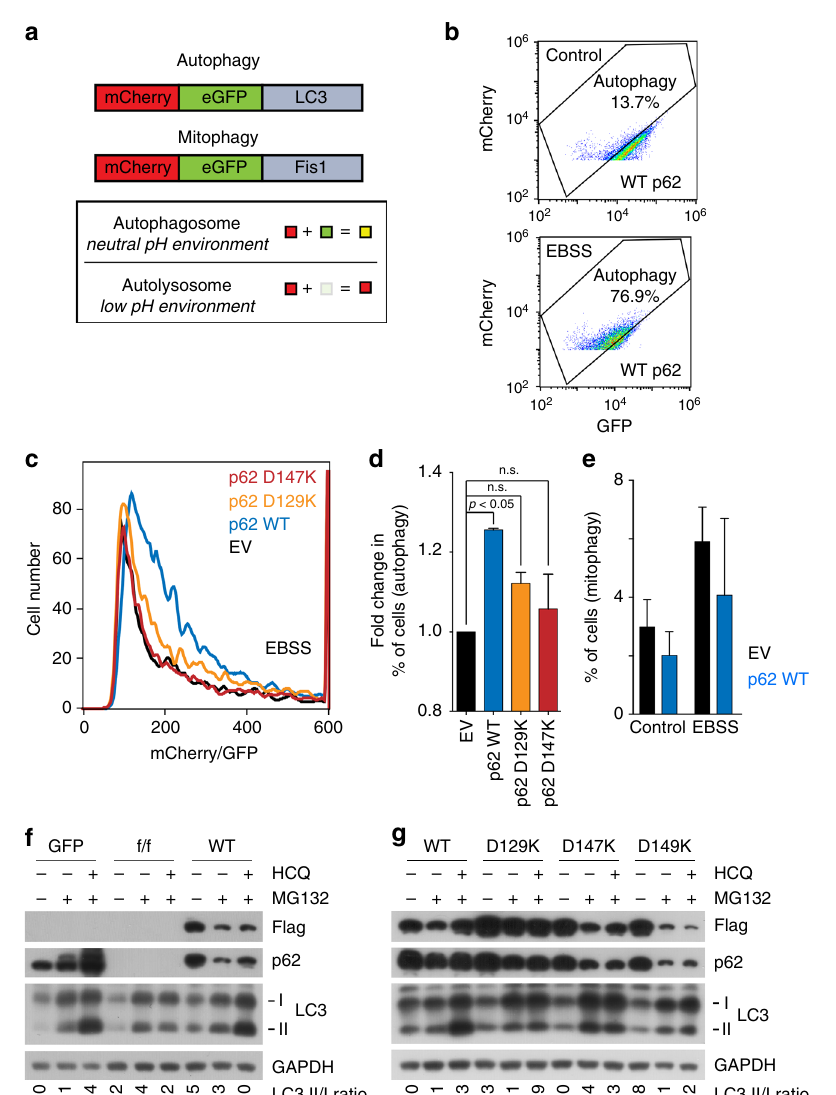
Fig. 4 p62zz is necessary for ef fi cient EBSS-induced macroautophagy. a Schematic of LC3 tandem and Fis-tandem fl ux assay. b An example of the LC3 tandem fl ow cytometry assay under basal conditions or starved (5% serum media in 95% EBSS media) conditions in p62 WT MEFs, where a decrease in GFP expression can be observed and quanti fi ed to measure the percent of cells undergoing autophagy. c Number of cells undergoing autophagy 24 h after starvation in 5% serum media in EBSS: measured by the decreased ratio of mCherry/GFP via fl ow cytometry in p62-/- MEFS with stable expression of an empty vector, WT p62, D129K p62 or D147K p62 and stable expression of mCherry-GFP-LC3 tandem (representative fi gure of two experiments). d Quanti fi cation of ( c ), where the percent of cells undergoing autophagy was normalized to the p62-/- condition. One-way ANOVA was performed on two independent experiments. e Normalized percent of cells undergoing mitophagy measured by the decreased ratio of mCherry/GFP via fl ow cytometry in p62-/- MEFS with stable expression of an empty vector, WT p62, D129K p62, or D147K p62 and stable expression of mCherry-GFP-Fis1 tandem. Error bar in d and e represents s.e.m with N of 2. f Western blot analysis of mouse p62 fl / fl embryonic fi broblasts infected with GFP or CRE adenoviruses were reconstituted with retroviruses expressing WT Flag-p62 or point mutants of Flag-p62 treated with/without MG132 (0.2 µ M, 24 h) in the presence or absence of hydroxychloroquine (10 µ M, 24 h). Ratio between LC3-II and LC3-I quanti fi ed by densitometry using ImageJ. g Similar to f but with